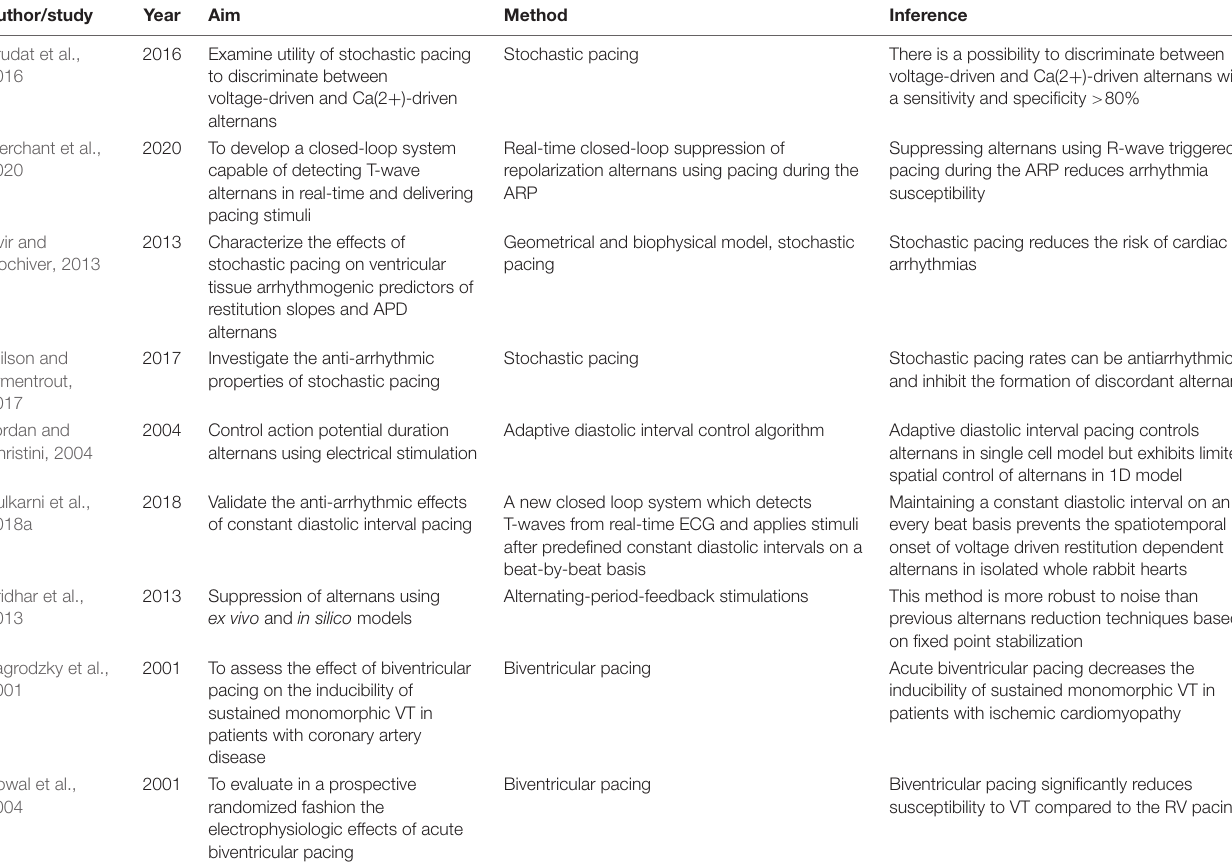
TABLE 2 | Prevention and control of cardiac arrhythmias: summary of novel pacing techniques for arrhythmia suppression.